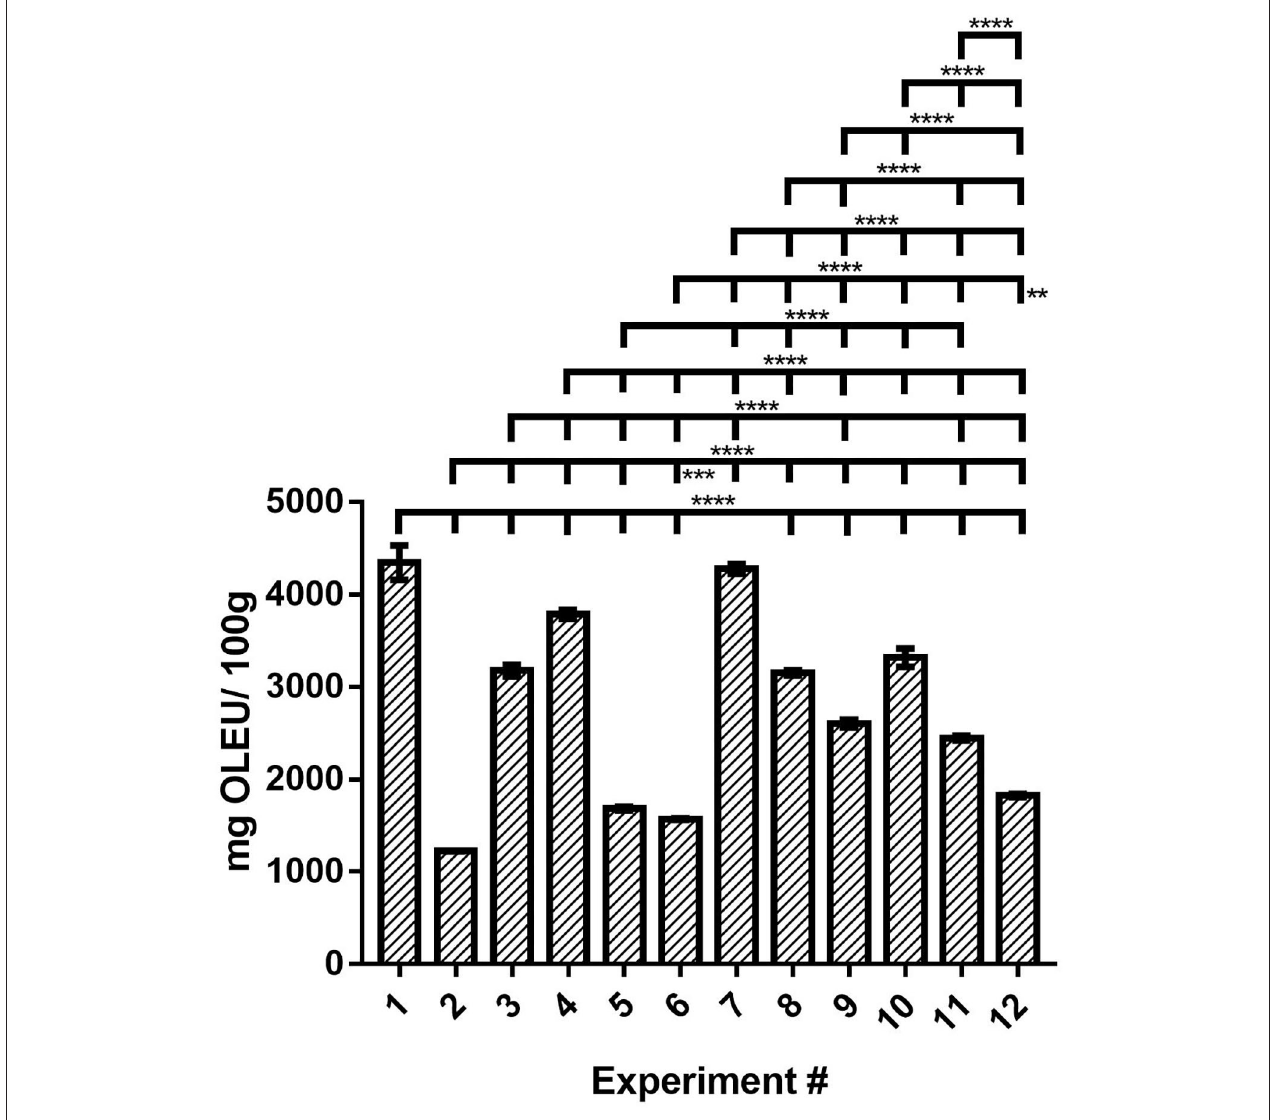
FIGURE 2 | OLEU concentration of OLEU-EE quantified by HPLC-DAD and comparison of mean ± SD values by one-way ANOVA with Tukey’s test of the OLEU content for the 12 experiments. With a confidence interval of 95% ( α = 0.05), significance is represented by brackets with two asterisks (**) identify adjusted P- values between 0.01 and 0.001, three asterisks (***) identify adjusted P- values between 0.001 and 0.0001, and four asterisks (****) identify adjusted P- values <